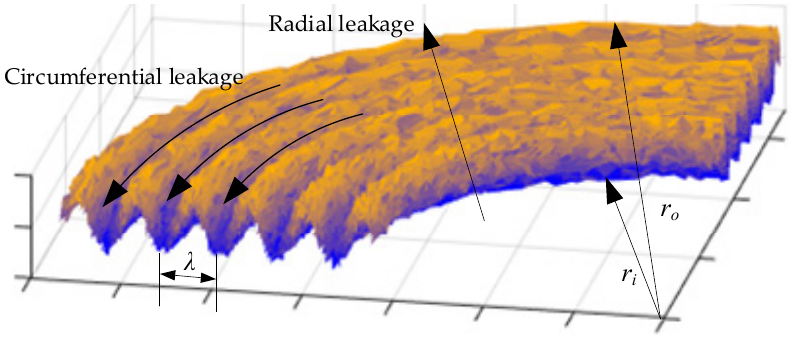
Figure 6. Schematic of the turning surface microstructure.